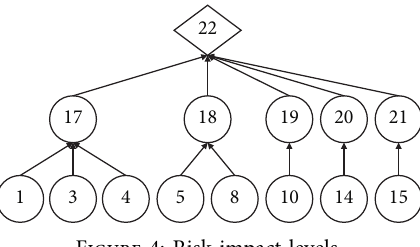
Figure 4: Risk impact